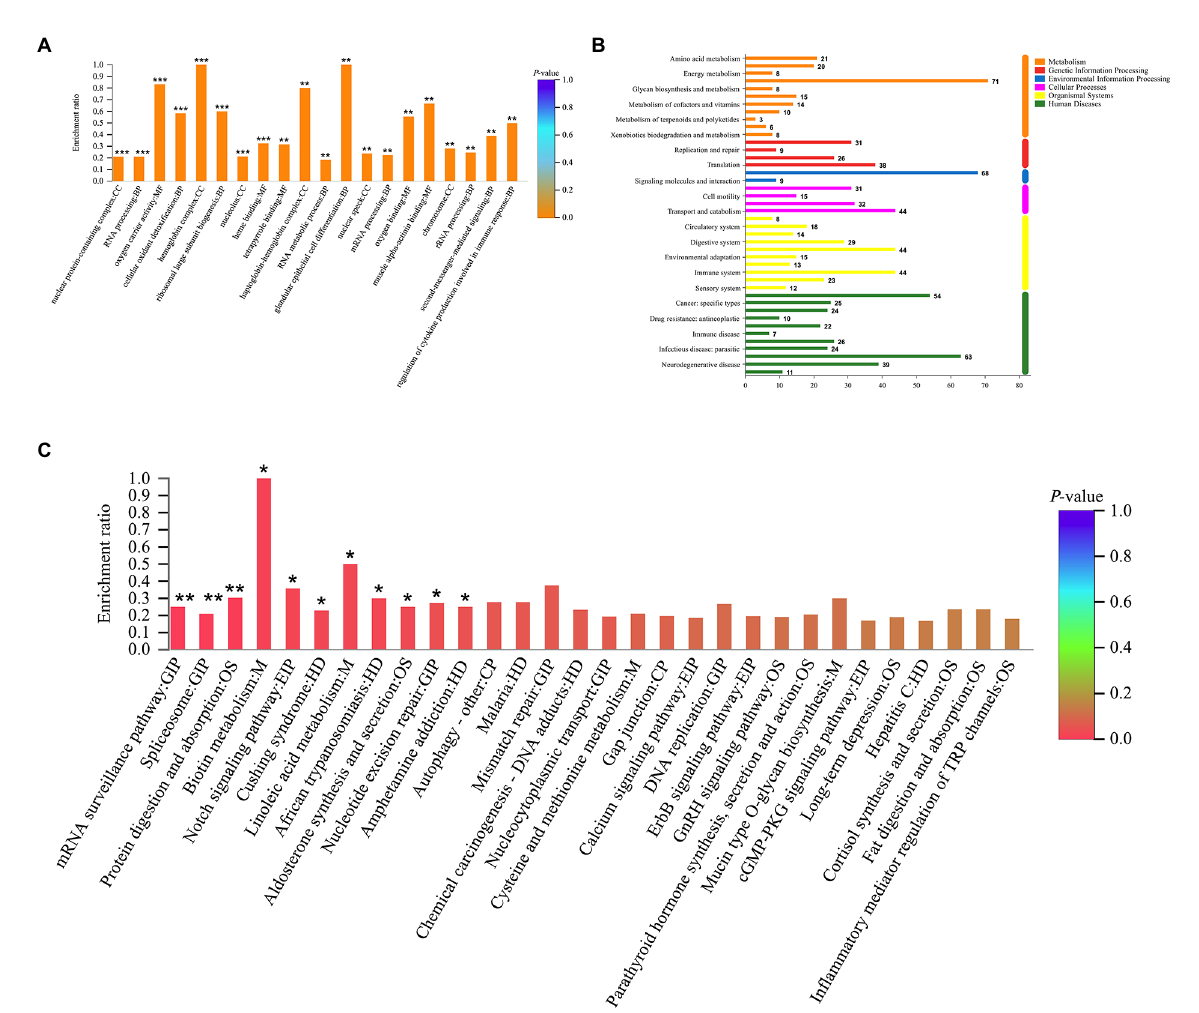
FIGURE 8 GO and KEGG analyses based on DEPs regulated by tuina treatment. (A) GO enrichment analysis, the abscissa represents the GO description and the Go term (level 1) and the ordinate represents the enrichment ratio, different colors represent statistical differences of enrichment; (B) KEGG annotation histogram, the horizontal coordinate represents the number of proteins, and the vertical coordinate represents KEGG pathways, different colors represent pathway categories; (C) KEGG enrichment analysis, the horizontal coordinate represents the pathway name and the vertical coordinate represents the enrichment ratio, different colors represent statistical differences of